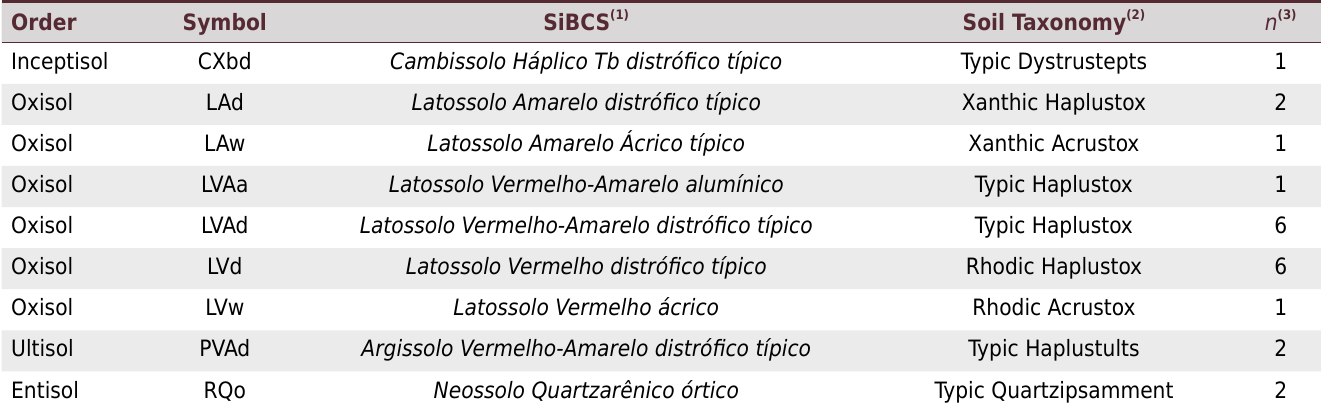
Table 1. Classification of the soils used in the lime incubation study Order Symbol Inceptisol Oxisol LAd Oxisol LAw